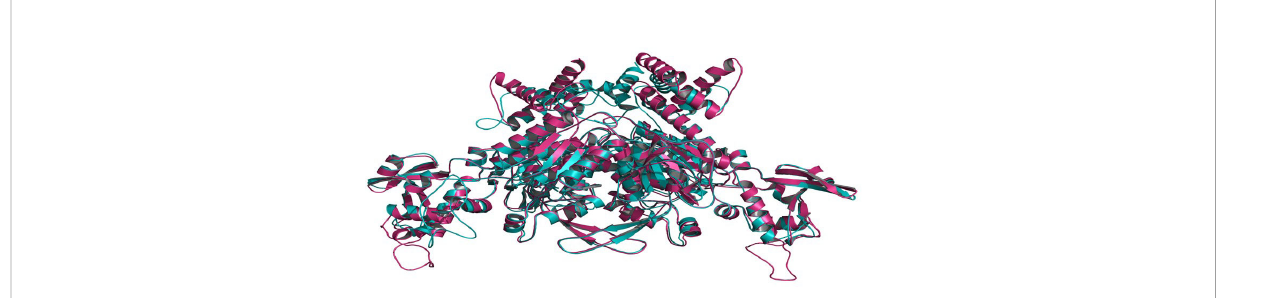
FIGURE 4 Superimposition of modelled CT-domain of ACCase protein of P. minor and T. aestivum to determine the dissimilarity between the modelled structures 0.975 Å.